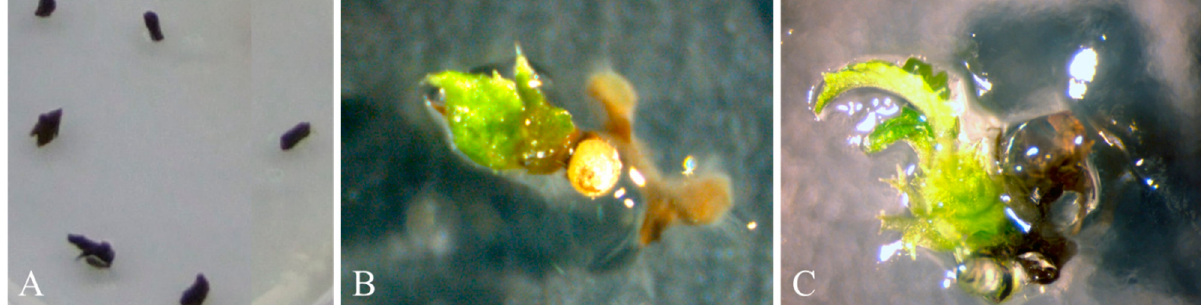
Figure 3. Corylus avellana , cultivated variety Tonda Gentile Romana. ( A ) Explant necrosis 4 weeks after thawing, ( B ) green explants 4 weeks after thawing, and ( C ) regrowing shoot 8 weeks after freezing.